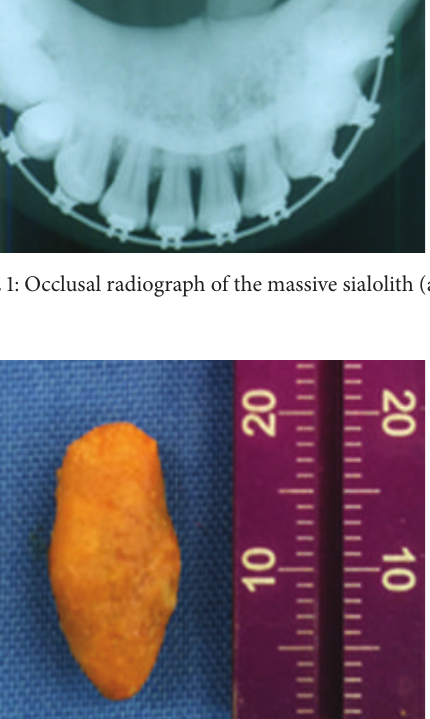
side of the floor of the mouth, with a purulent discharge.